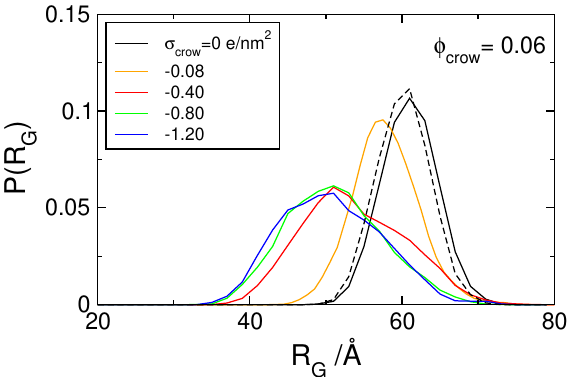
Figure 1. Probability distribution of the radius of gyration P ( R G ) , of the polyion in the absence (dashed line) and presence of crowding agents ( Φ crow = 0.06) with varying charge density, as